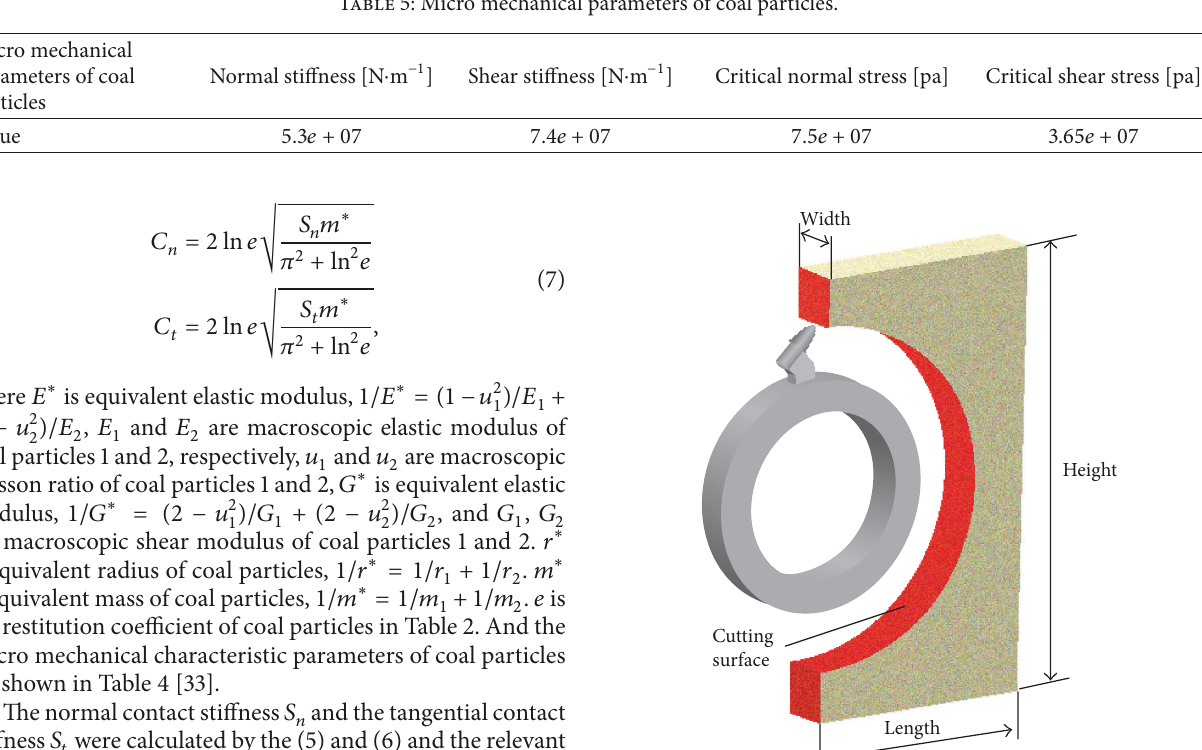
Table 5: Micro mechanical parameters of coal particles.